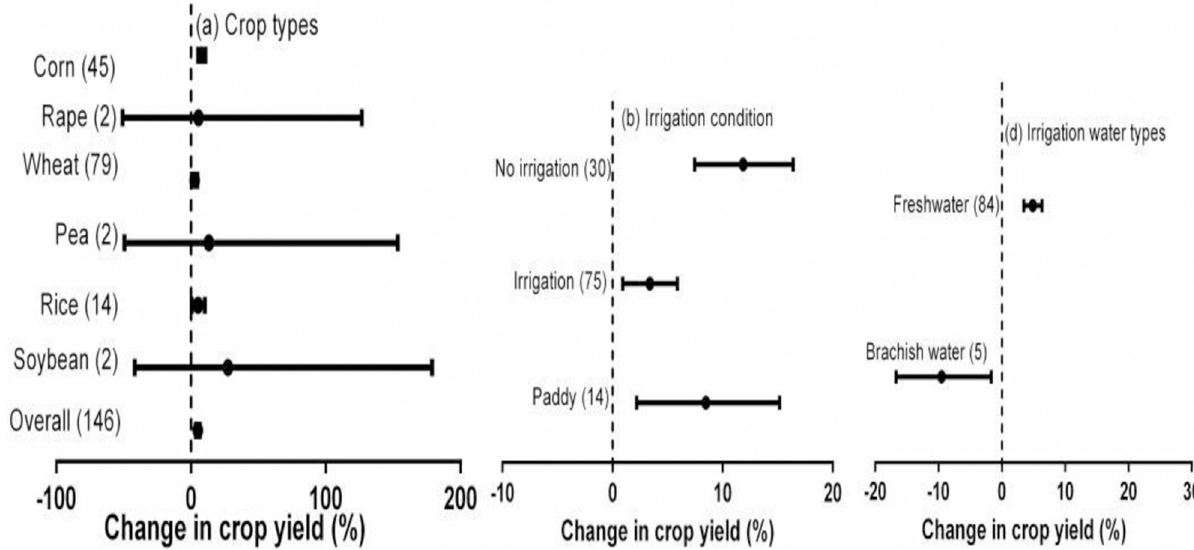
Fig 3. Effect of crop residue return on crop yield for: (a) different crop types; (b) irrigation conditions; (c) irrigation water type. Error bars represent the mean value ± 95% CI.